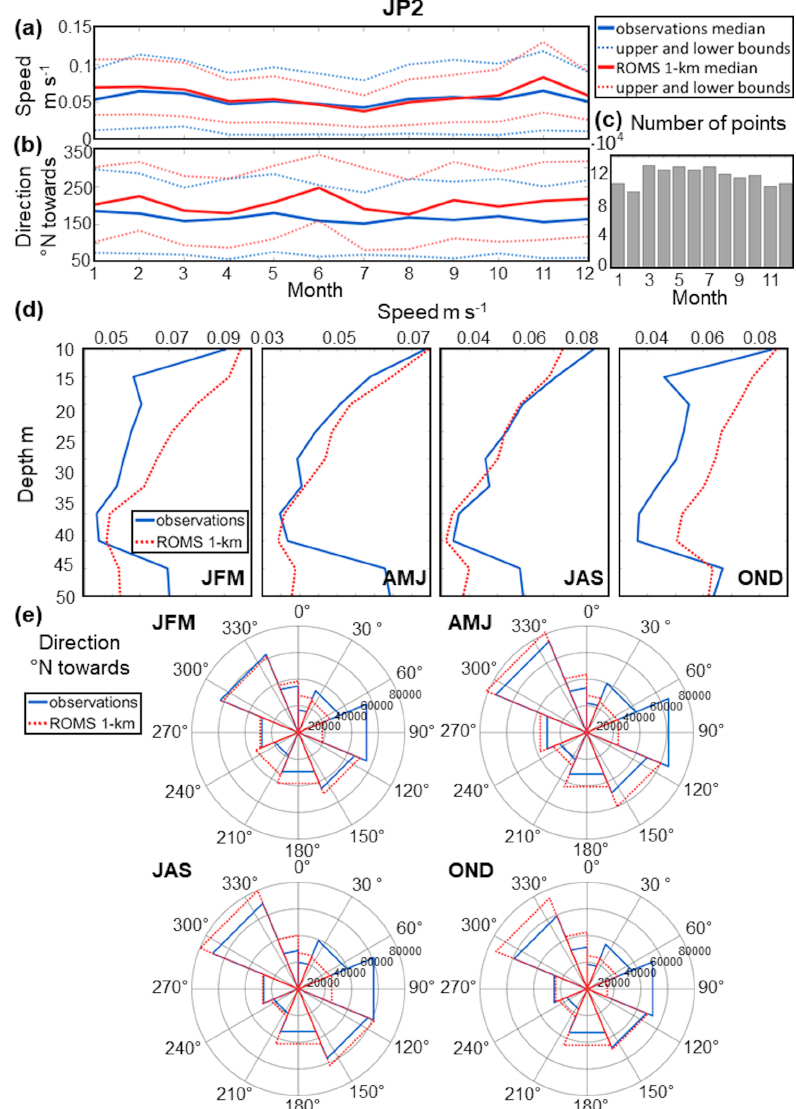
Figure 13. JP2 dataset. Monthly climatology of AdriSC 1km and in situ (a) median speed, (b) median direction, and their variabilities (i.e. upper and lower bounds defined as ± MAD) as well as (c) the number of observations per month. Seasonal variations of the (d) speed of the AdriSC ROMS 1km model and observations depending on the depth. Seasonal rose plots of the (e) direction for ADCP observations and the AdriSC ROMS 1km